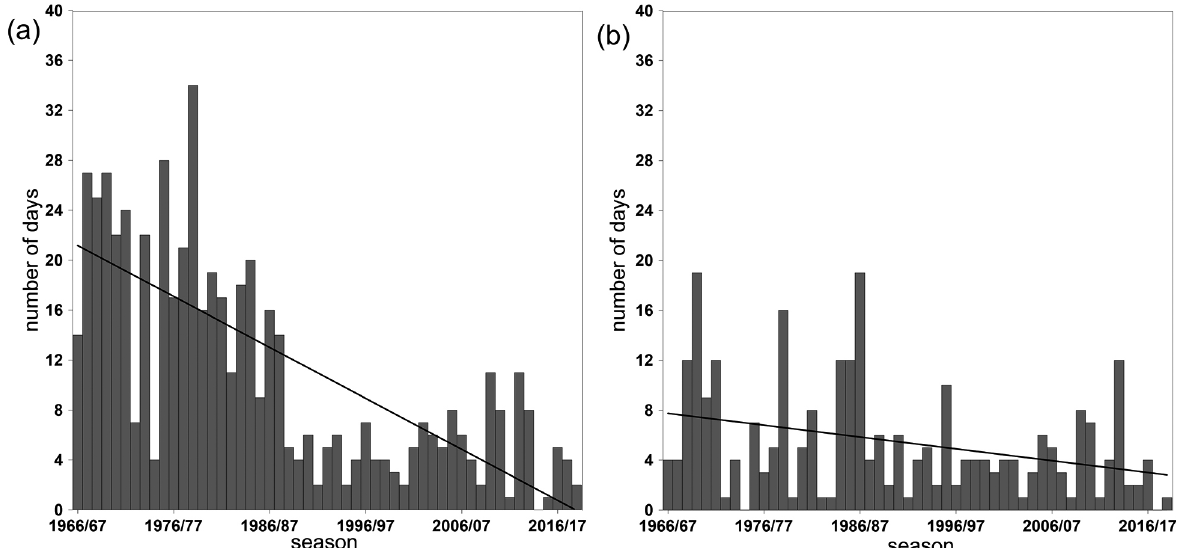
Fig. 3. Multiannual variability of seasonal (November–March) number of days with very strong or extreme cold stress according to UTCI in Suwałki (A) and Warszawa (B), 1966/67 to 2018/19. Solid lines represent respective trends. UTCI, Universal Thermal Climate